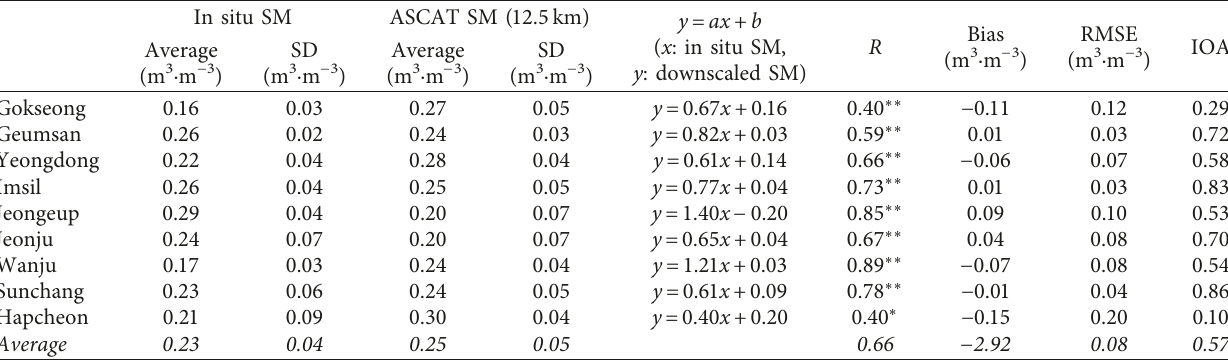
Table 5: Comparison between in situ and original scale (12.5km) ASCAT SM.